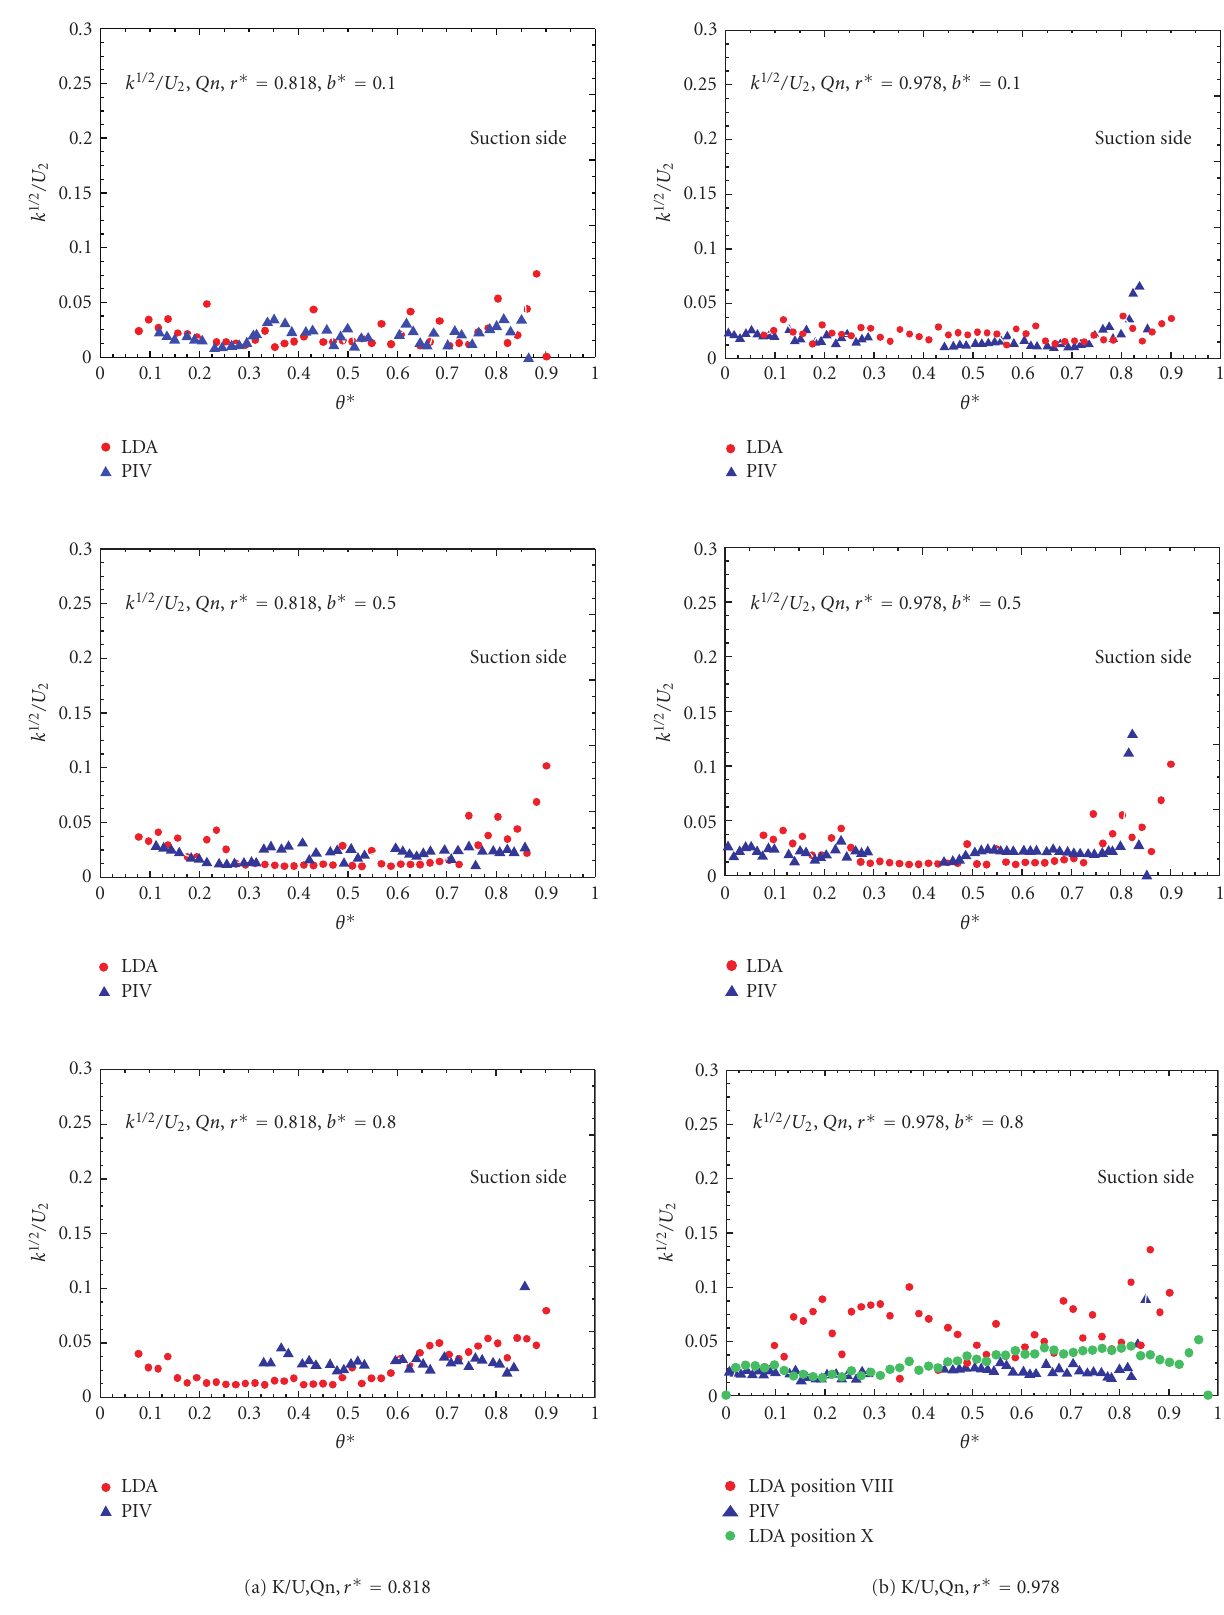
Figure 8: Velocity fluctuation rates deduced from PIV and LDV